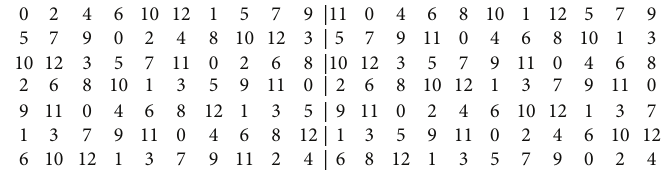
Figure 3: 12 - 𝐿(2,1) -labeling of 𝐶 7 ⊠ 𝐶 21